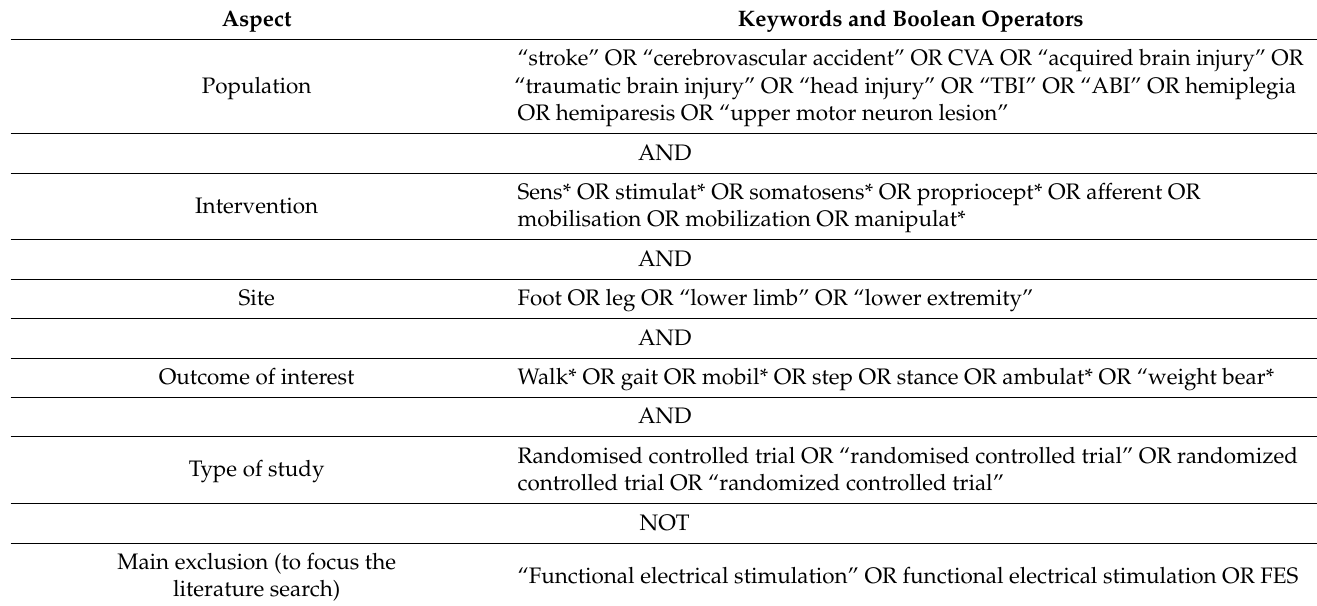
Table 1. Search strategy for systematic